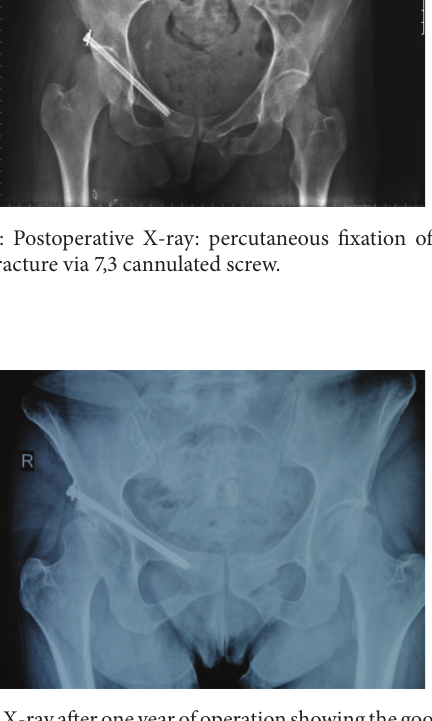
Figure4:X-rayafteroneyearofoperationshowingthegoodclinical